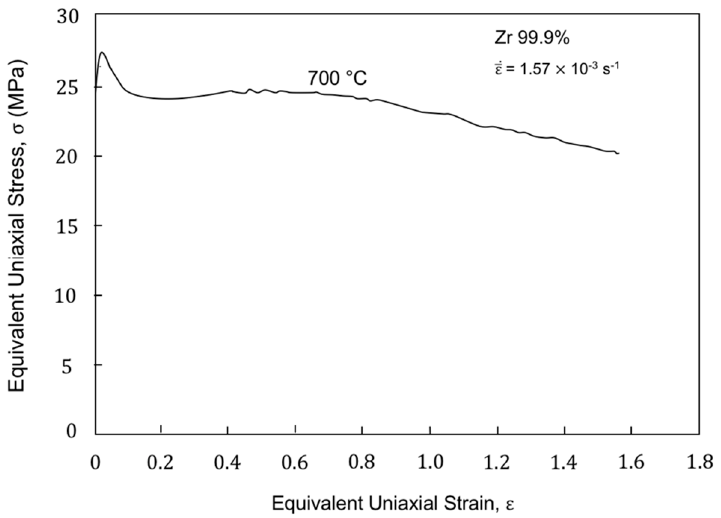
Figure 2. Equivalent uniaxial stress vs. strain behavior of α -zirconium deformed in torsion at 700 ◦ C (0.46 T m )